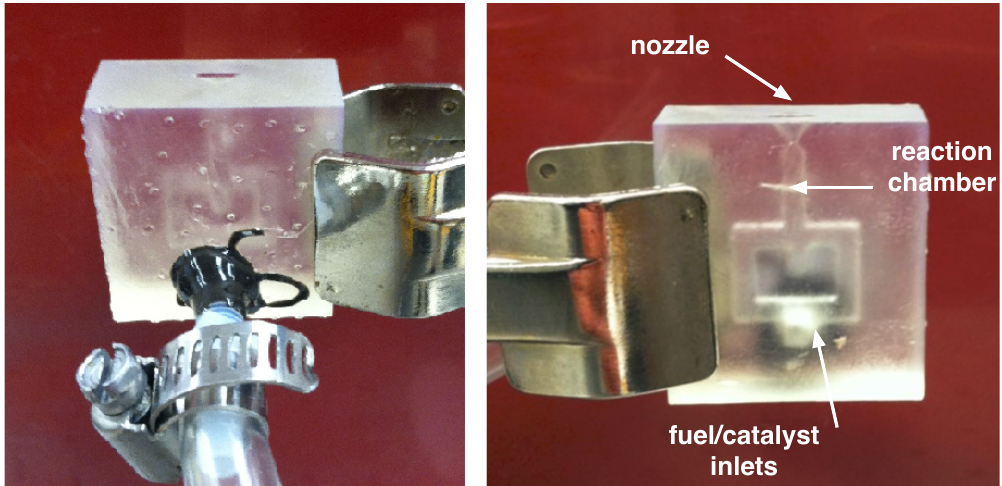
Figure 10. Nozzle with 30 degree half angle used for verification of supersonic flow in the test region of the in-house Schlieren photography system. The photo on the left shows the house air connection which was secured with epoxy, the photograph on the right shows the simplified flow network and nozzle half